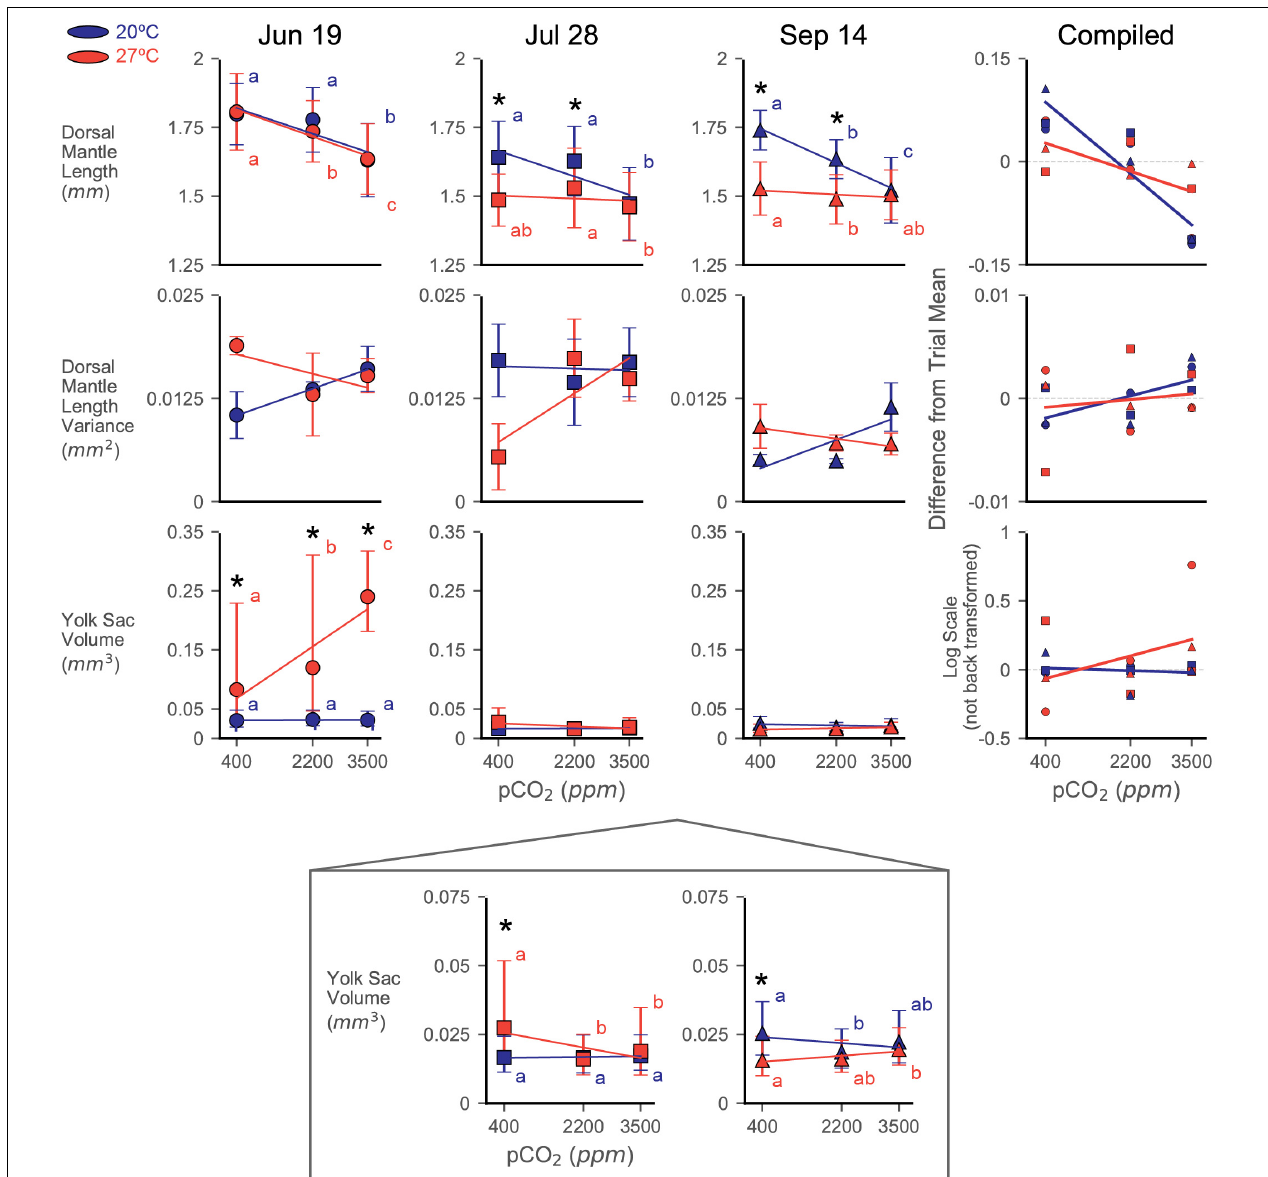
FIGURE 2 | Dorsal mantle length, its variance, and YV data from three experiments rearing squid eggs under acidification (in parts per million CO 2 ; x -axis) and warming (color; blue/dark = 20 ◦ C, red/light = 27 ◦ C). Yolk data were transformed to logarithmic scale for statistical analyses and has been back transformed for the depiction of trial data. A zoom box is provided beneath the July 28 and September 14 YV plot in order to see statistical difference and trends. Symbols represent trial, demarcated by dates eggs were laid (titles). Symbols depict means with error bars of one standard deviation. Letters indicate statistical groups across acidification levels within a temperature treatment from a Tukey’s HSD. Asterisks indicate statistically significant differences between temperature treatments at the same acidification level. Regression lines are presented primarily as an aid to visualizing trends in the data and are not intended to indicate statistical power. The compiled plots show data from all trials normalized by subtracting the average value for a trial from its data; relative differences in yolk data have not been back transformed from the logarithmic scale. Error bars have been removed and symbols shrunk in order to emphasize trendlines.